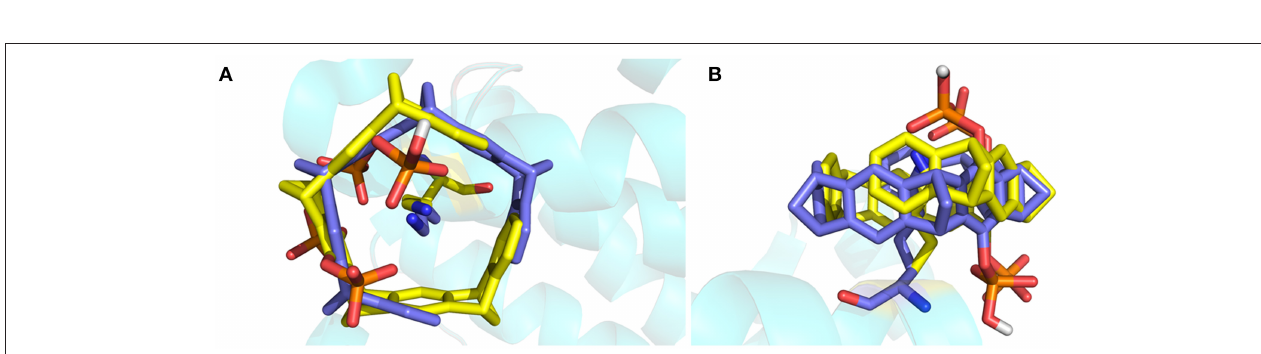
FIGURE 2 | Cartoon representation for the classification of all surface exposed lysine residues of 14-3-3 σ . Two chains are colored in red and cyan, respectively. (A) I-type, (B) II-type, (C) III-type, and (D) IV-type.